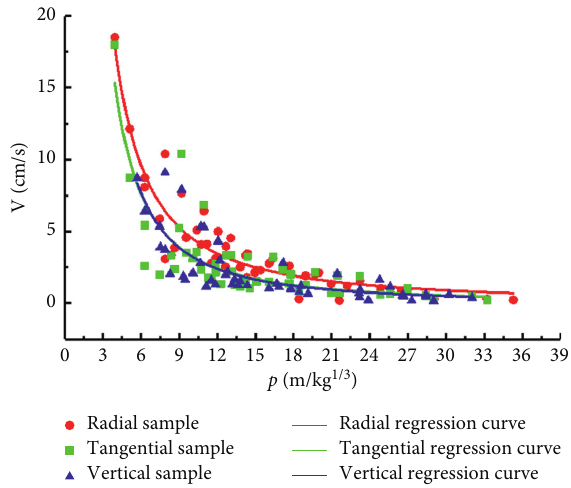
Figure 8: The velocity sample and regression curve of three-di- rectional